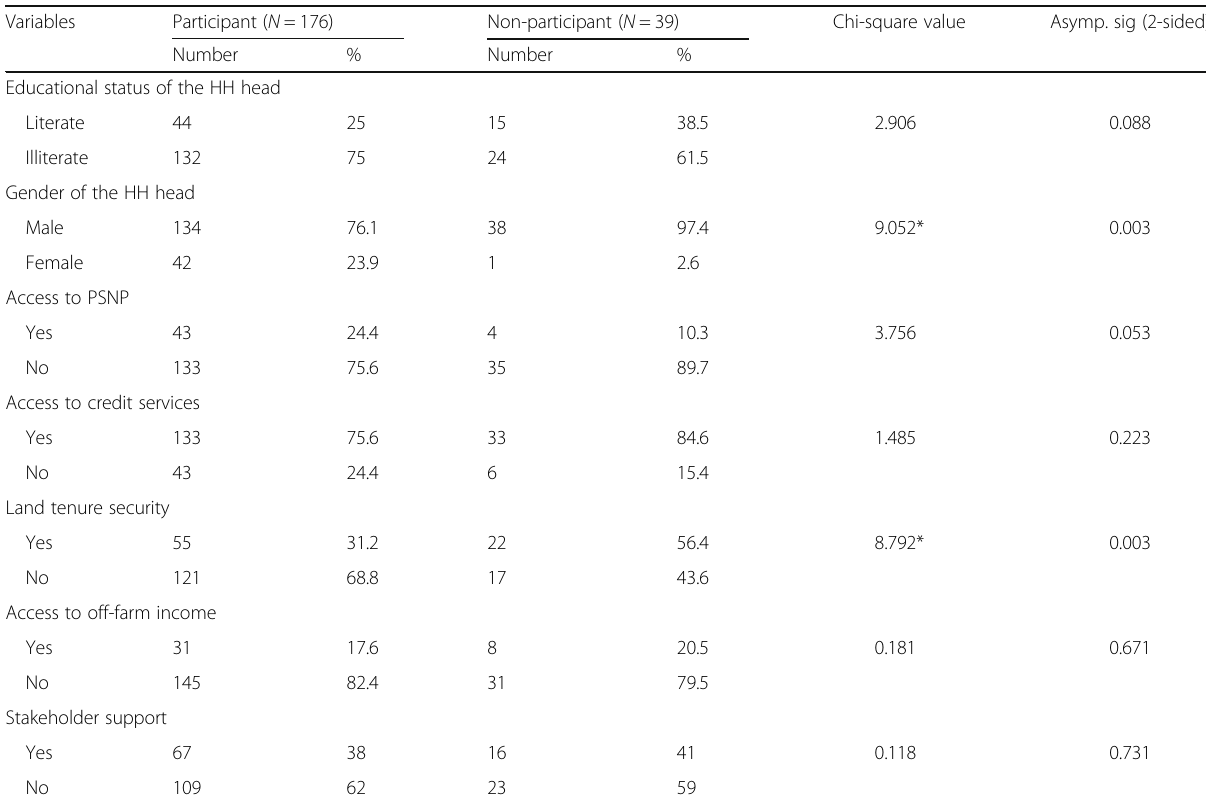
Table 5 Descriptive summary of discrete